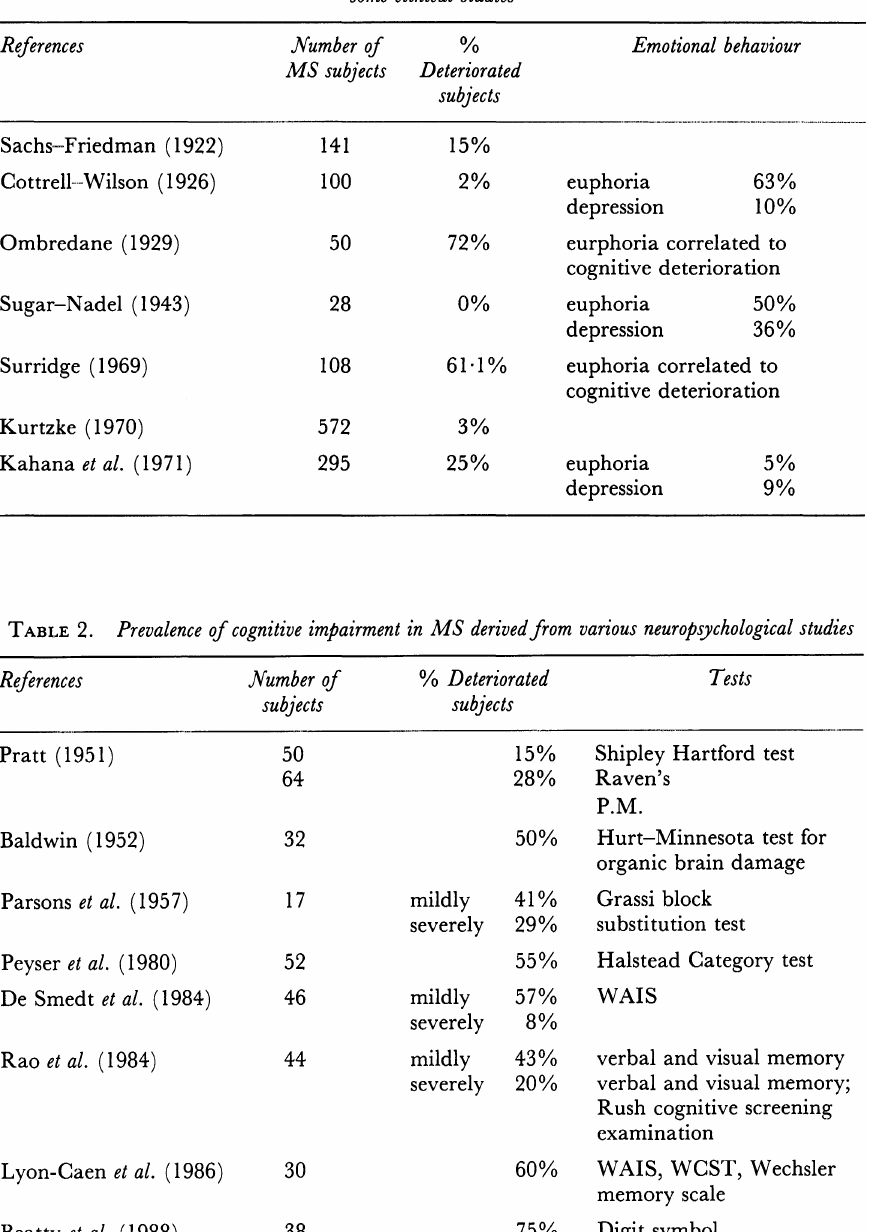
TABLE I. Prevalence of cognitive deterioration and associated emotional behaviour in MS derived from some clinical studies